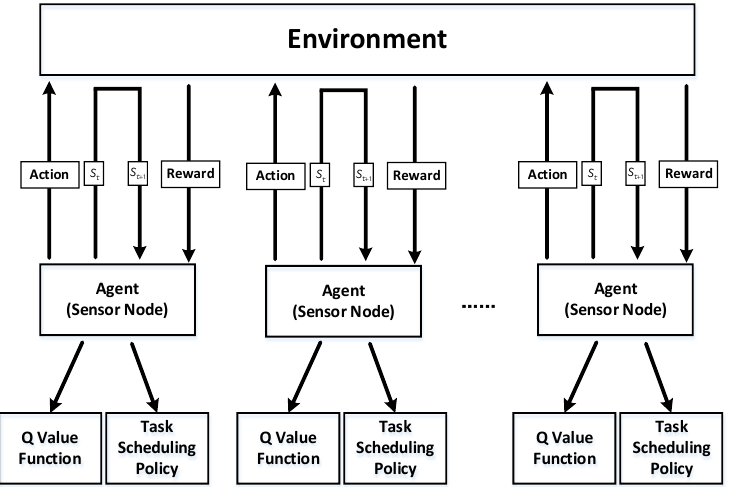
Figure 2. Proposed task-scheduling mechanism based on